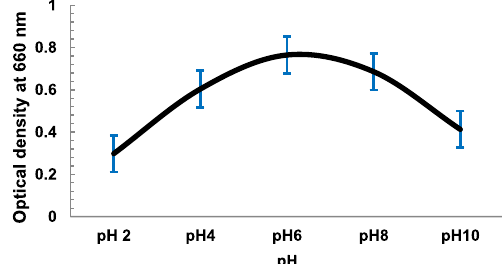
Fig. 5. pH Dependent growth of Kanchengayao glacier isolates and others were Pseudomonas fluorescens, Pseudomonas reactants, Pseudomonas hibiscicola and Pseudomonas synxantha . The accession number and identity of all the isolates are given in Table 5. The phylogenetic tree was made using MEGA7 using the Neighbor-Joining method Fig.